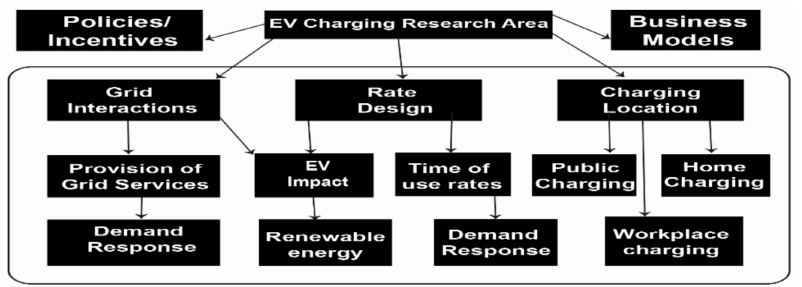
Figure 12. UK EV charging protocol and charger to car connection research analysis